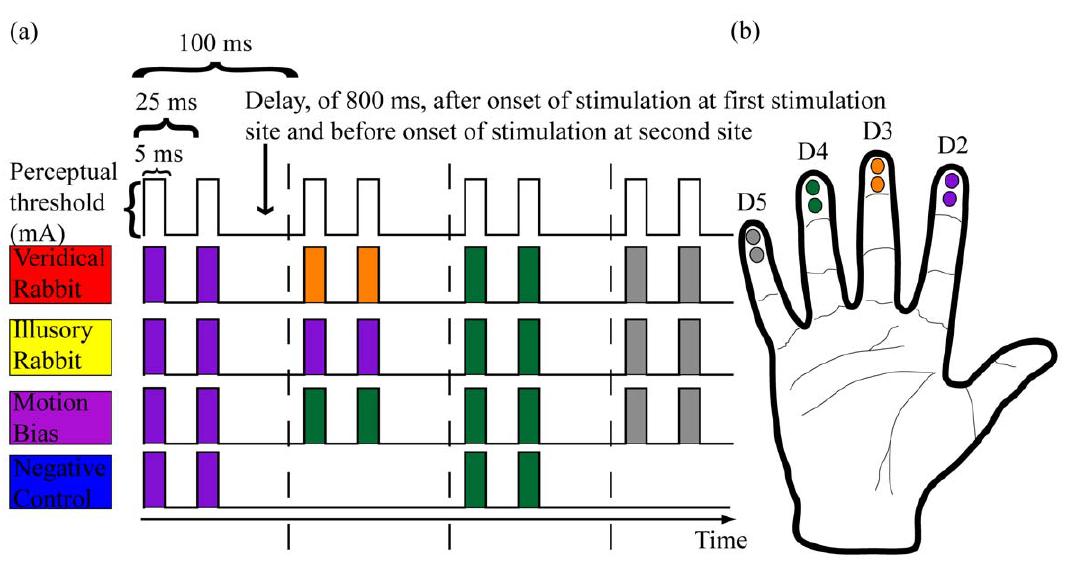
Figure 1. Schematics of stimulus sequences and electrode locations on fingertips. (a) Schematics of the four stimulus train types. All pulse widths are amplitude modulated to subject perceptual threshold for a particular stimulation site. Color is indicative of the stimulation site and/or train type. (b) Diagram of electrode locations on fingertips.